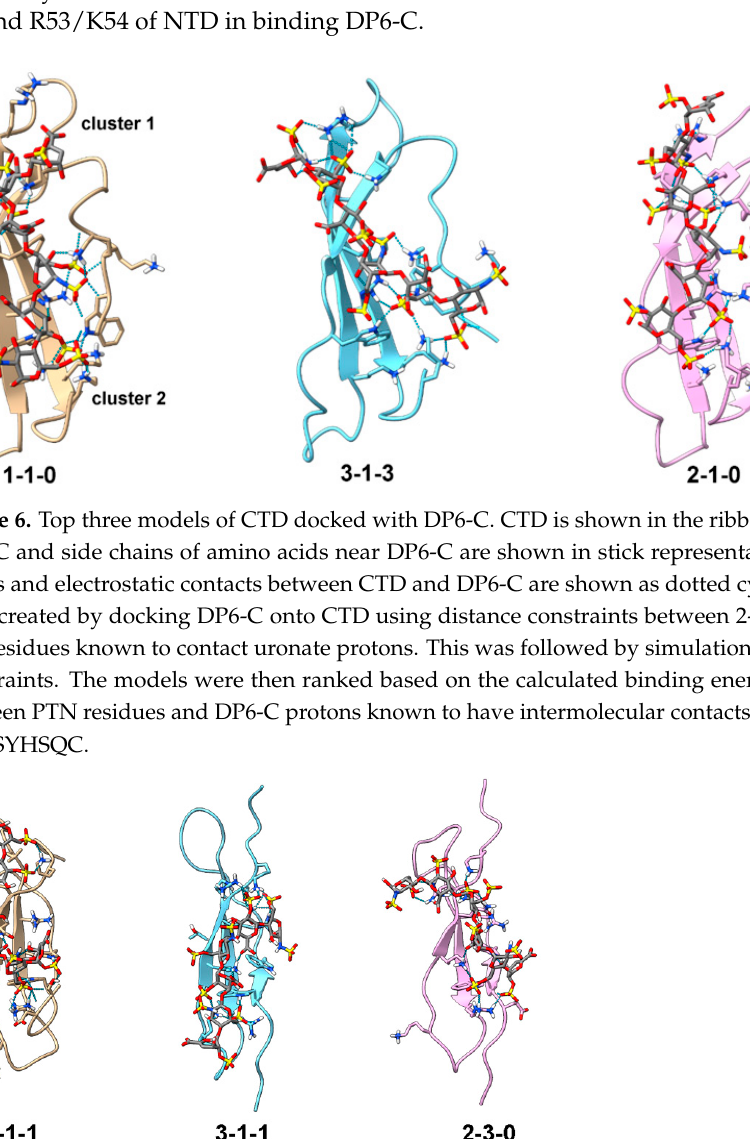
Figure 7. Top three models of NTD docked with DP6-C. NTD is shown in the ribbon representation. DP6-C and side chains of amino acids near DP6-C are shown in stick representations. Hydrogen bonds and electrostatic contacts between CTD and DP6-C are shown as dotted lines. Models were created by docking DP6-C onto NTD using distance constraints between 2-O-sulfate groups and residues known to contact uronate protons. This was followed by an MD simulation without distance constraints. The models were then ranked based on the calculated binding energy and distances between PTN residues and DP6-C protons known to have intermolecular contacts in the 15 N-edited NOESYHSQC.